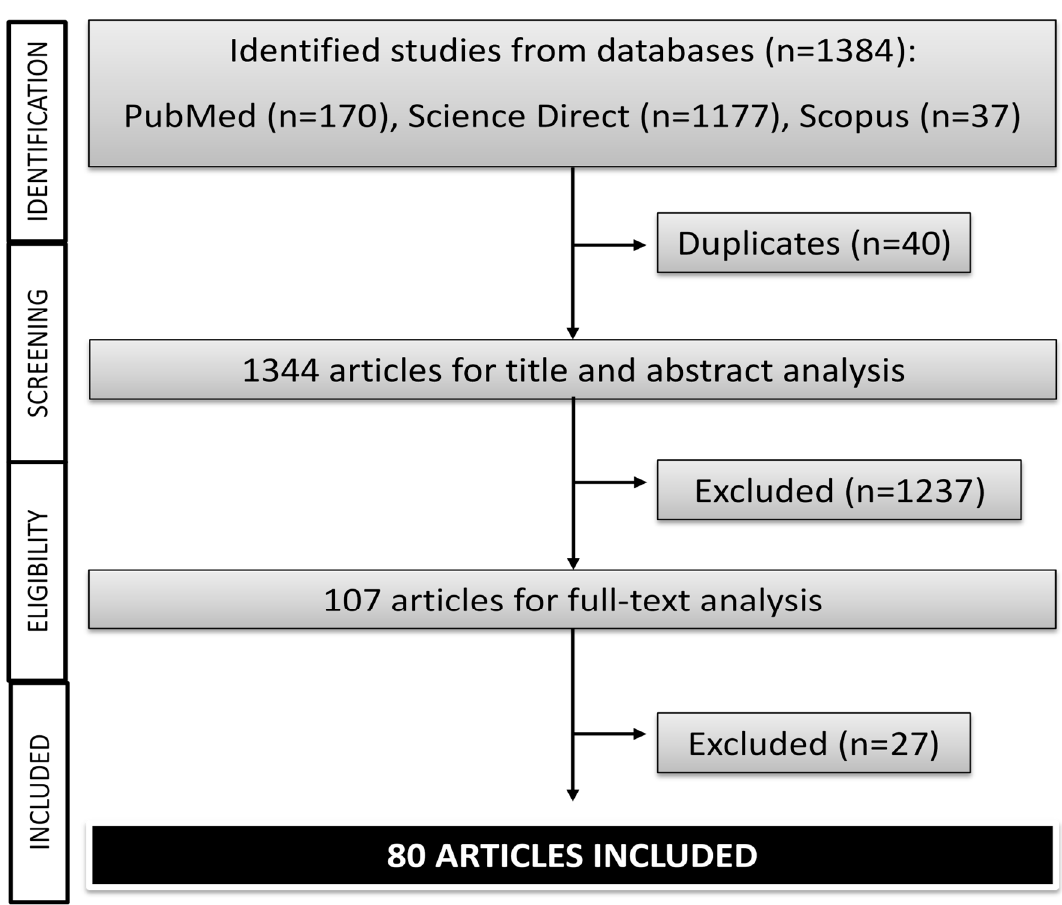
Figure 1 . Flowchart of the literature research ( in vitro , in vivo , and clinical trials studies) of Camellia sinensis .